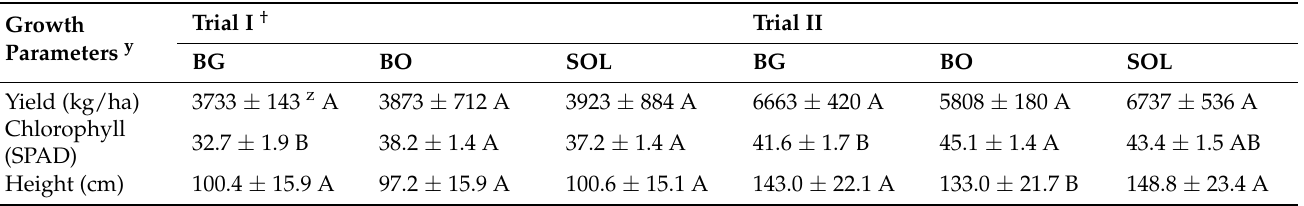
Table 4. Effects of no-till cover cropping with black oat ( Avena strigosa ) on corn growth, yield, and weed pressure.